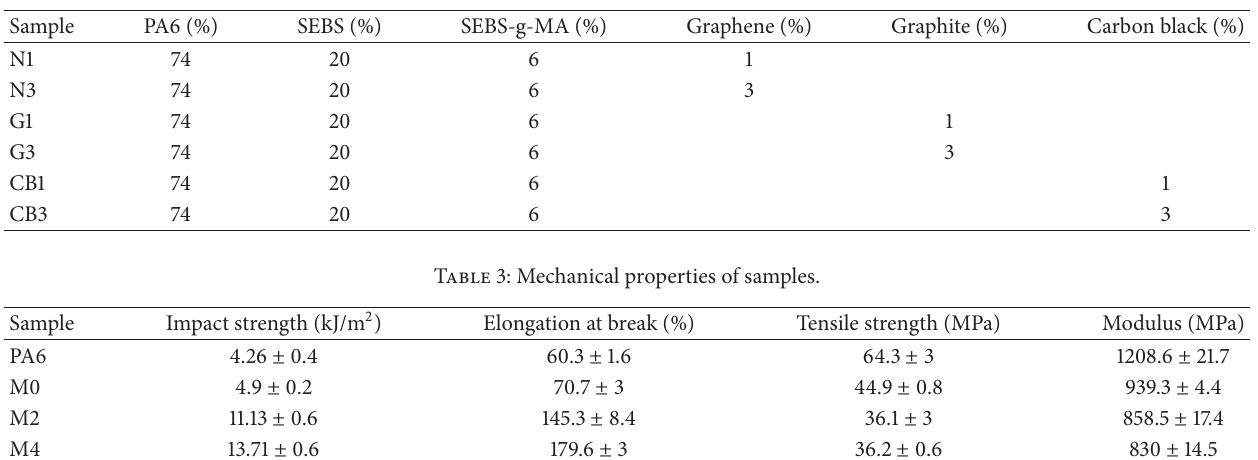
Table 2: Formulation of the nanocomposites samples.